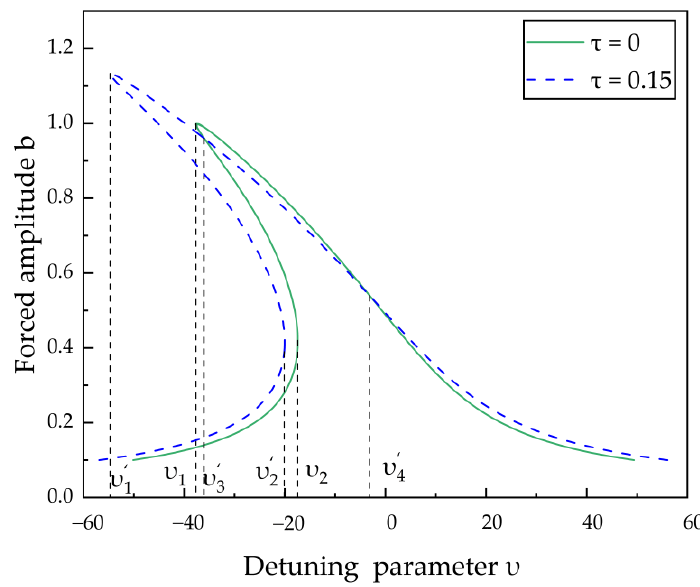
Figure 3. Frequency response curves of the micro-beam.